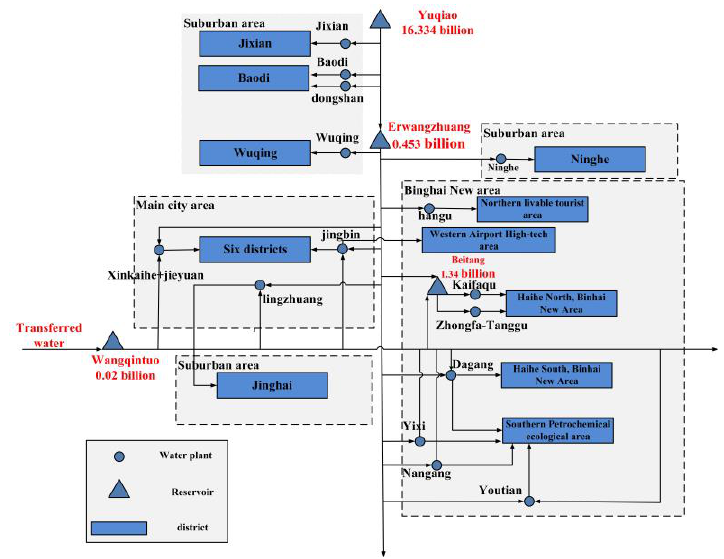
Figure 7. Tianjin ’ s urban water supply network. Figure 7. Tianjin’s urban water supply